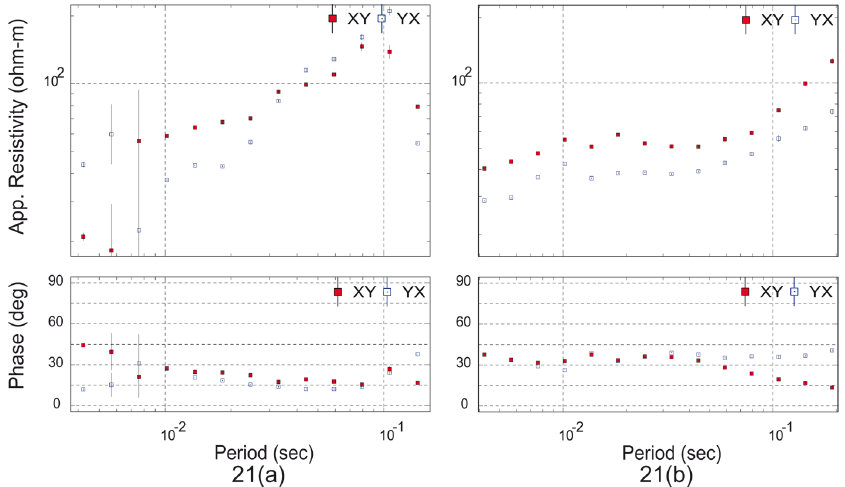
Figure 21. Interrelation between FFT length and Parzen radius in case of a large data set of 1 KHz of site K11 with 1,228,800 data points. (a) Apparent resistivity (upper panel) and phase (lower panel) curves obtained from the data using a FFT length 512 and a Parzen radius 0.6 (b) Apparent resistivity (top panel) and phase (bottom panel) curves obtained applying a FFT length 16384 and a Parzen radius of 0.05 on the same data set. Considering a large data set, a large FFT length and a small Parzen radius provide a better outcome. The red colored boxes indicate XY components and the blue colored boxes indicate YX components of apparent resistivity and phase.